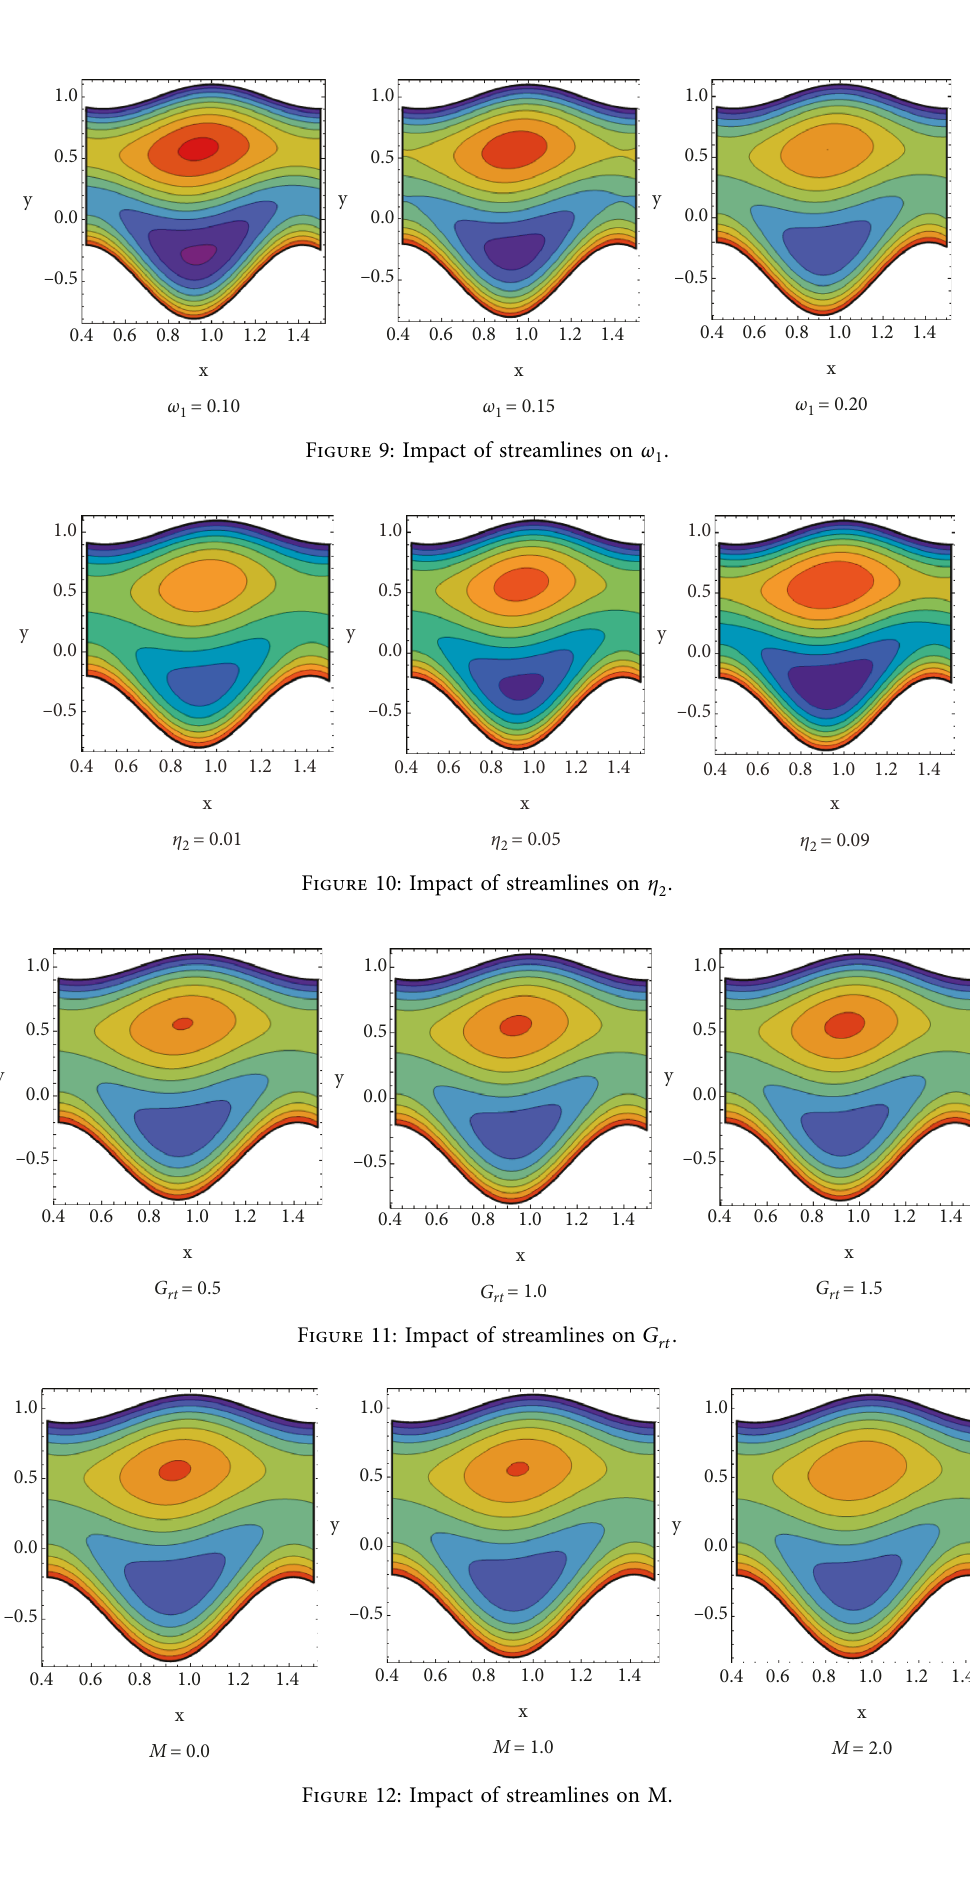
Figure 12: Impact of streamlines on